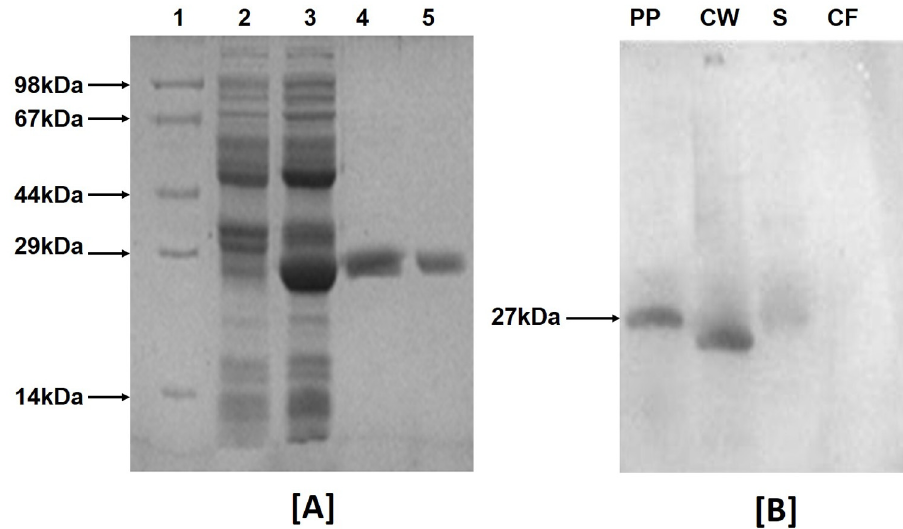
Fig 1. (A) SDS-PAGE analysis of purified Rv3203 protein: Lane 1, protein marker; lane 2, culture pellet uninduced; lane 3, culture pellet induced with IPTG; lanes 4 – 5, Rv3203 purified protein. (B) Western blot analysis for localization of Rv3203 in M . tuberculosis sub-cellular compartments. lane 1; rRv3203 purified protein (PP), lane 2; cell wall proteins (CW), lane 3; cytosolic proteins (S), lane 4; culture filtrate proteins (CF). Data represent one of the three